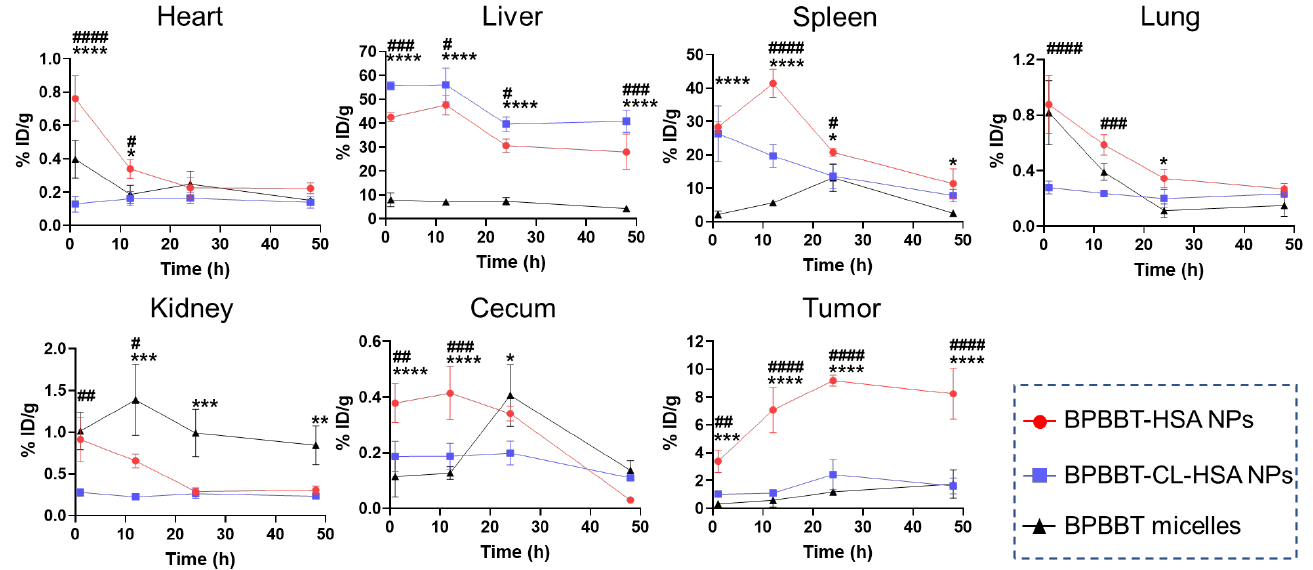
Figure 4. Biodistribution of BPBBT in mice bearing CT26-Luc orthotopic tumor at 1, 12, 24 or 48 h